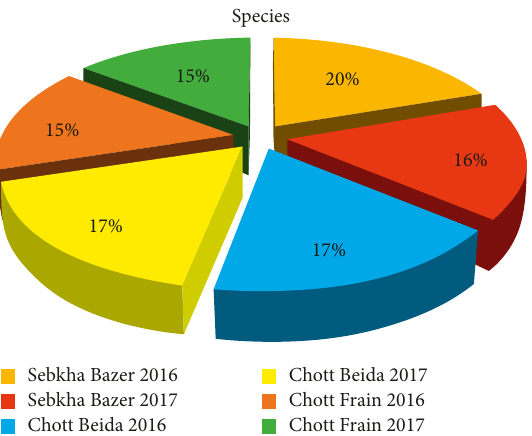
Figure 5: Percent of entomofauna according to their numbers of species in all three studied sites in saline wetlands during study period